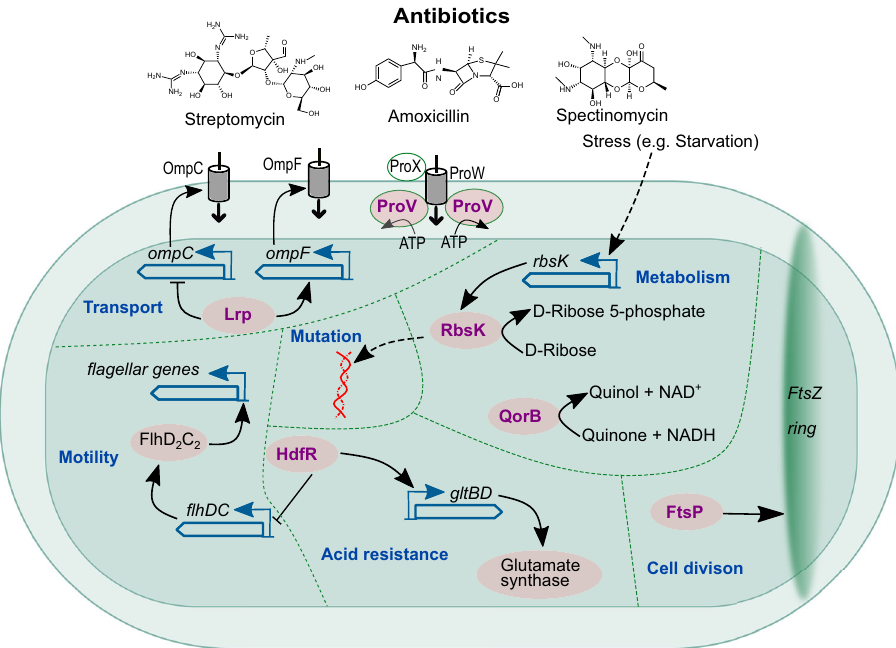
Fig. 6 Mode of action of 6 previously unknown genes discovered to be involved in antibiotic resistance. The proteins of these genes are shown in purple. Solid arrows indicate upregulation while blocking bars indicate downregulation. Dotted arrows indicate indirect